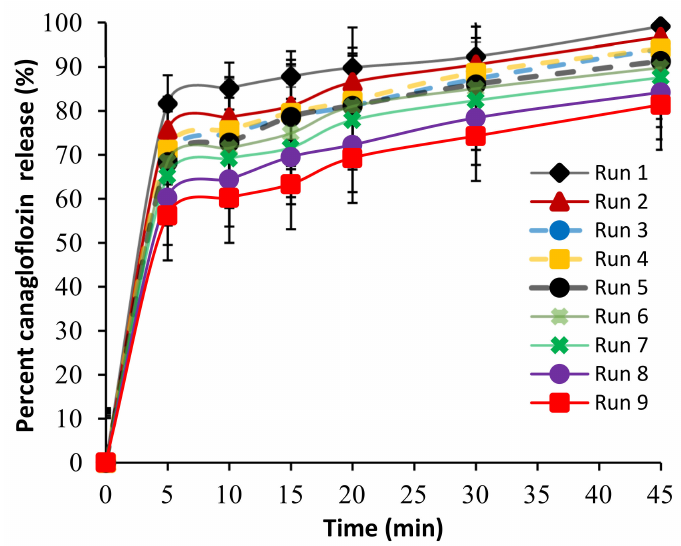
Figure 3. Release profiles of canagliflozin tablets according to 3 2 full-factorial